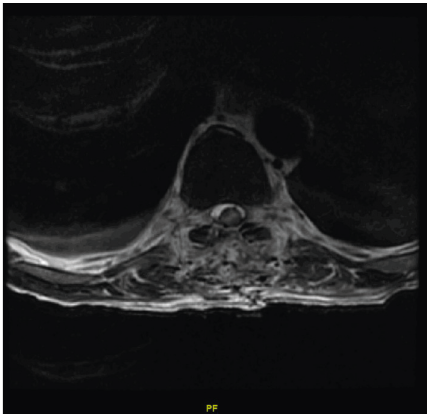
Figure 4: Postoperative MRI axial view showing the little fluid collected at the intradural and extramedullary space where the tumor was